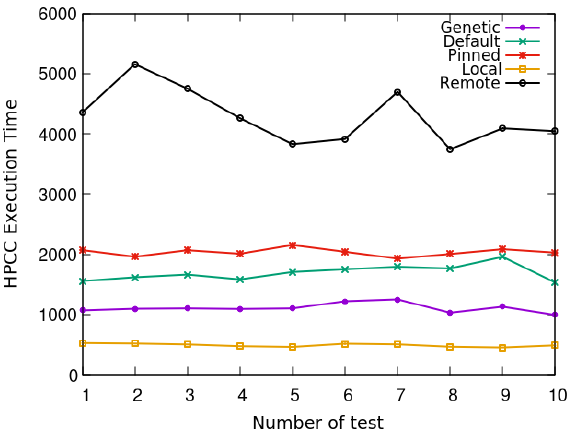
Figure 7. Mapping 16 virtual cores to 40 physical